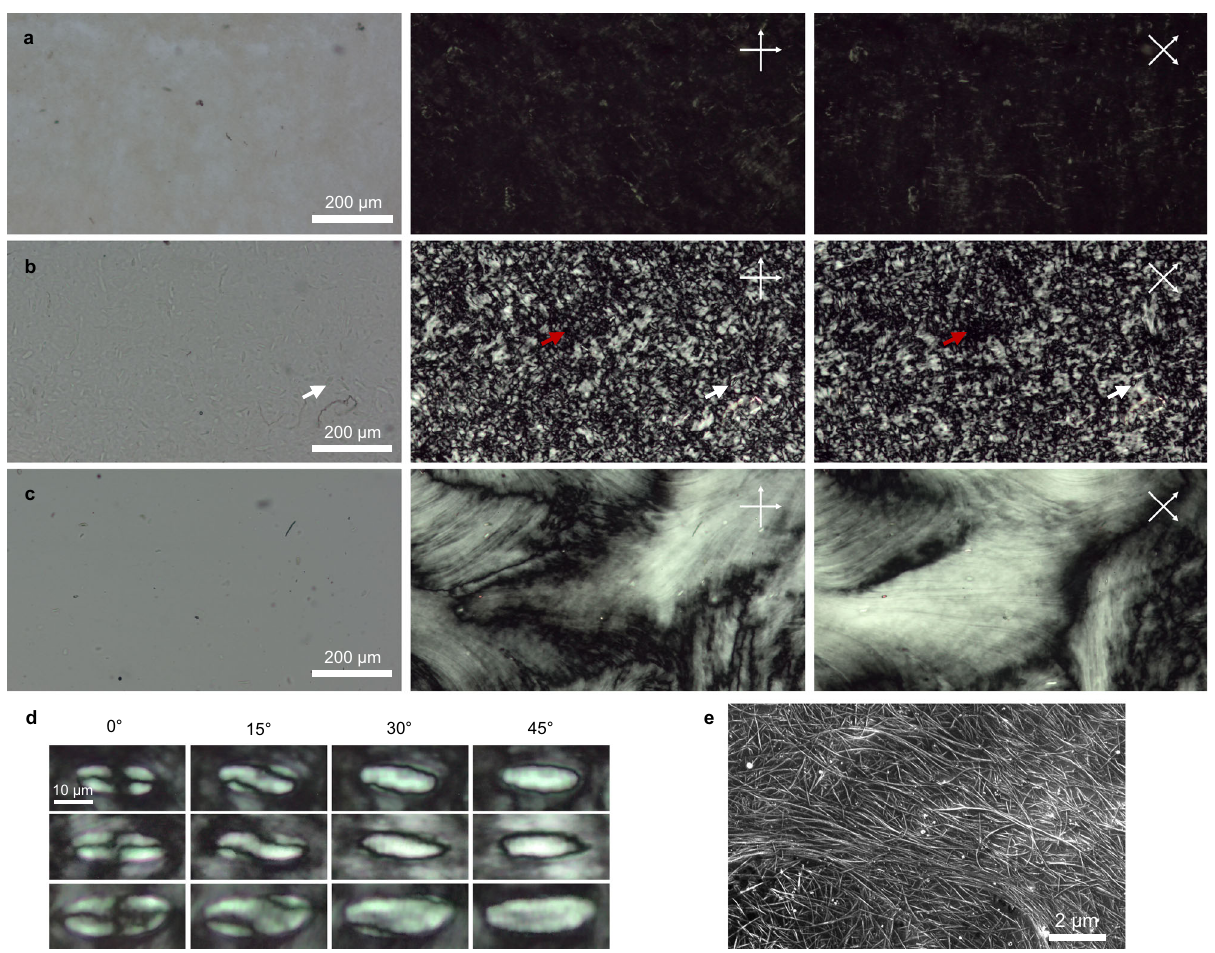
Fig. 2 Liquid crystals of BNNTs. Polarized light microscopy (PLM) of BNNTs in chlorosulfonic acid (CSA) in fl ame-sealed 1 mm × 0.1 mm rectangular capillaries ( a – c ): unpolarized transmitted light and polarized light images with polarizer/analyzer at 0°/90° and 45°/135°, as depicted by the white crossed arrows. a Solution of lightly puri fi ed BNNTs (LP-BNNTs) at 7000 ppmw showing an isotropic solution with few birefringent domains. b Solution of highly puri fi ed BNNTs (HP-BNNTs) at 7260 ppmw showing 20 μ m regions of strong birefringence. White arrows in b highlight the same elliptical structure in all three images. Red arrows highlight the same isotropic region in both polarized images. c Solution of HP-BNNTs at 7260 ppmw (the same solution as b ) after ~5 s of bath sonication of the fi lled capillary. d High magni fi cation PLM images after dilution of the solution in b to 3000 ppmw showing three different tactoids between crossed-polarizer and analyzer at various angles. The scale bar is 10 μ m for all tactoid images. e Cryogenic scanning electron micrograph of BNNTs in CSA at 8000 ppmw showing aligned and isotropic regions in a biphasic BNNT